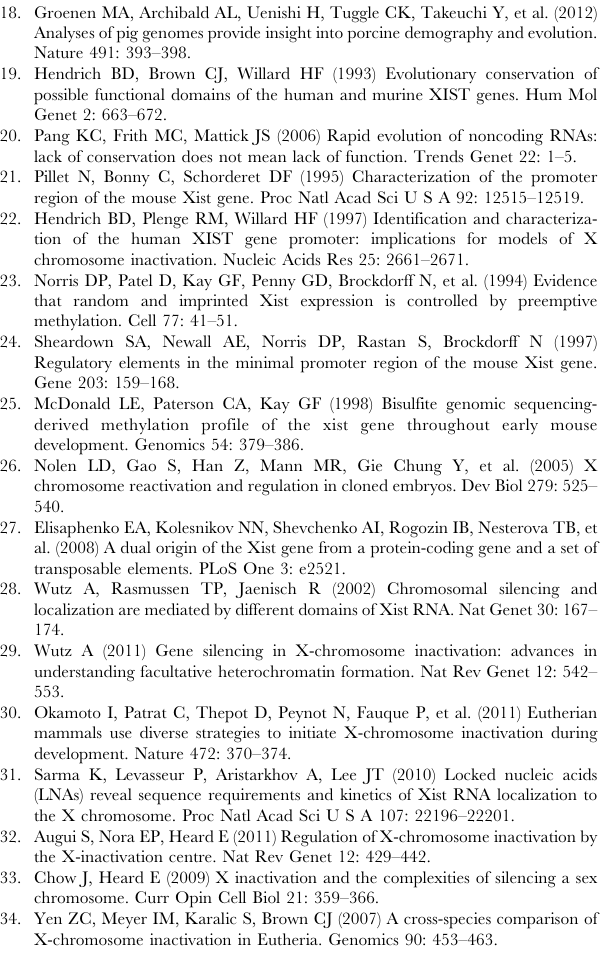
Table S1 The List of primer pairs sequence for reverse transcription PCR. Table S2 List of restriction enzymes used for each amplicon and the predicted sizes of the digested fragments. Table S3 List of primer pair sequences for 5`- and 3`- RACE- PCR. Table S4 List of primer pairs for bisulfite